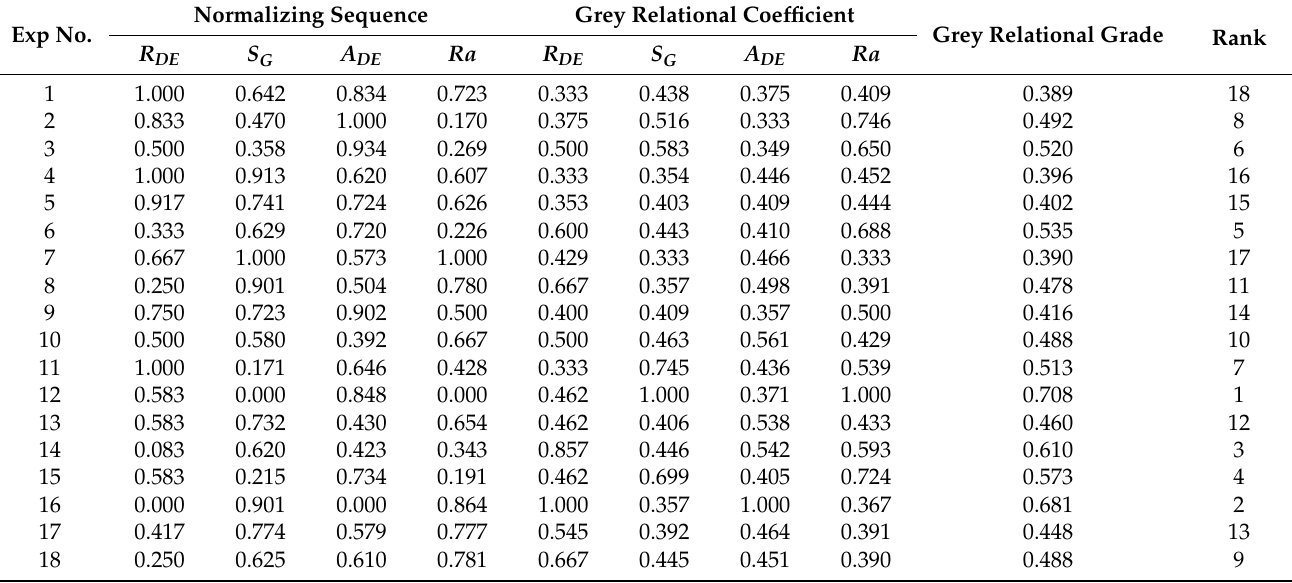
Table 7. Multi-objective optimization using grey rational analysis.